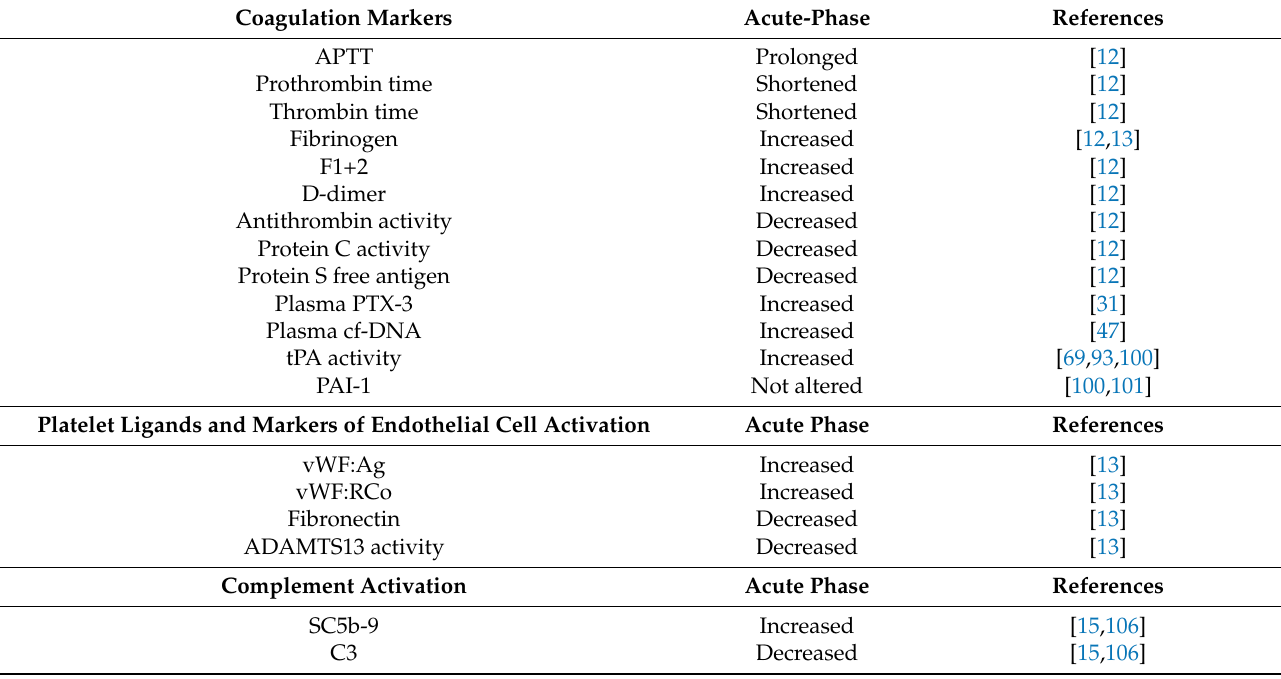
Table 1. The main alterations in the laboratory markers of coagulation, endothelial cell activation, and complement system in acute Puumala hantavirus